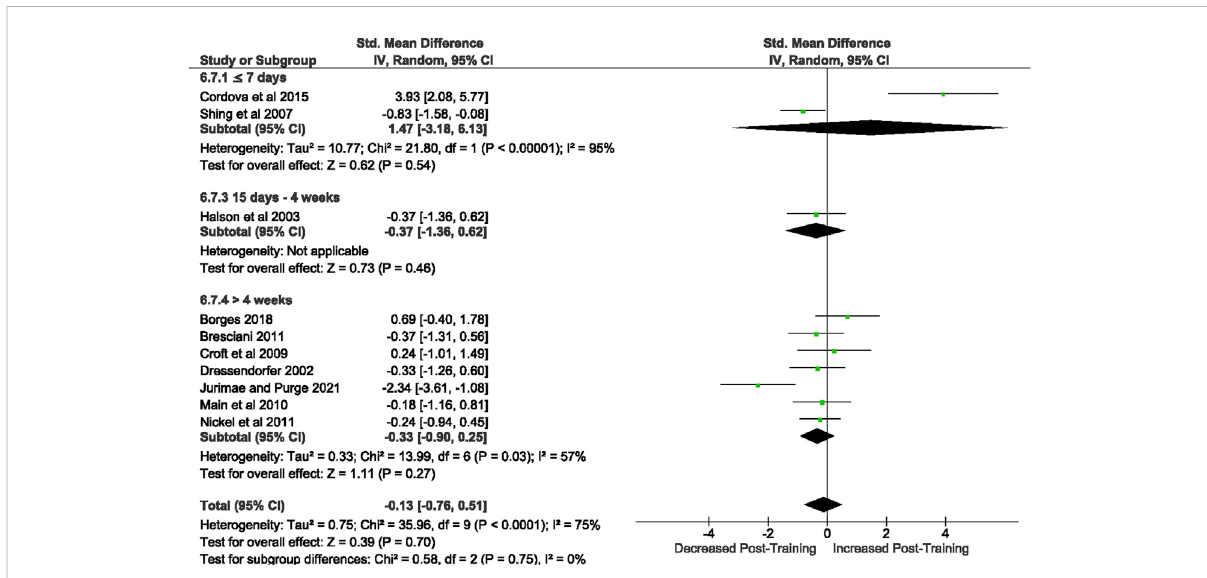
FIGURE 8 Effect of intensi fi ed training on resting unstimulated plasma TNF- α . Subgroup analysis is based on the duration of intensi fi ed training period; ≤ 7 day, 8 days — 2 weeks, 15 days — 4 weeks and > 4 weeks. All studies used human participants. CI Con fi dence interval.